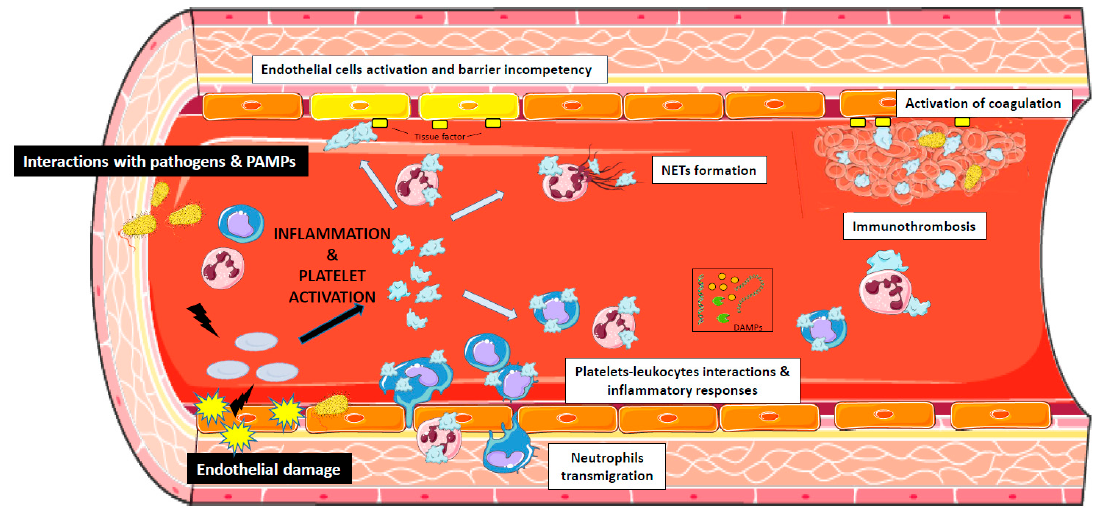
Figure 1. Selected examples of pro-inflammatory role of platelets during sepsis: endothelial damage and interactions with pathogens such as pathogens-associated molecular patterns (PAMPs) activate platelets that interact with endothelium, with monocytes and neutrophils, promoting neutrophils extra-cellular Trap (NET)osis, neutrophils transmigration, activation of coagulation through tissue factor release and immunothrombosis. DAMPs: damage associated molecular patterns (microvesicles, free DNA, protease).